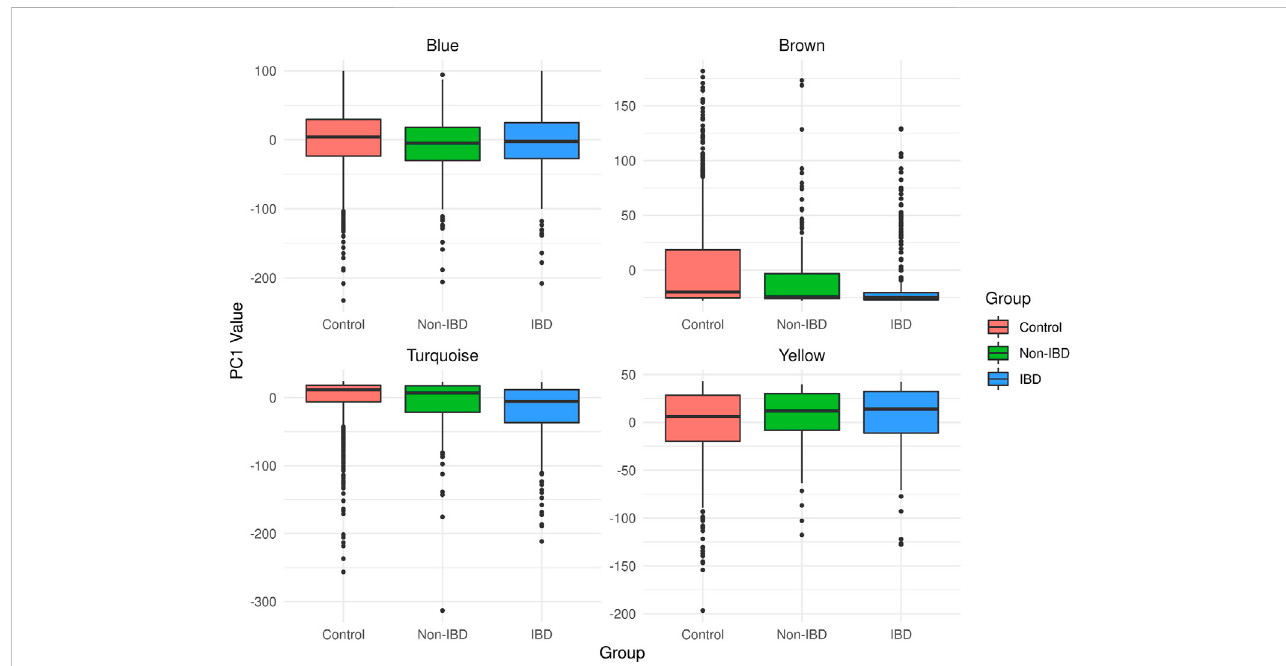
FIGURE 3 Boxplots of the microbial module QT distributions in the combined control cohort as well as in affected (IBD) and unaffected (non-IBD) IBD-KC individuals.